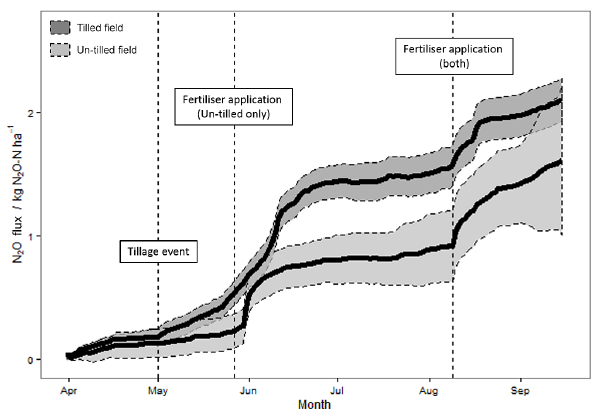
Figure 8. Cumulative flux is calculated for the tilled (dark grey) and untilled fields (light grey) using the gap-filled flux data. The cumulative 95% confidence intervals are shown (grey areas). Fer- tiliser was applied to the untilled field on 28 May and to both fields on 9 August and tillage occurred on 1 May (black dashed vertical